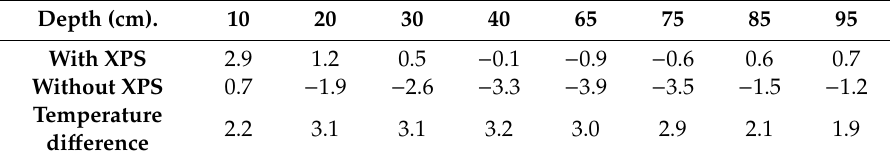
Table 7. Average temperature at di ff erent depths during the monitoring period ( ◦ C). Depth